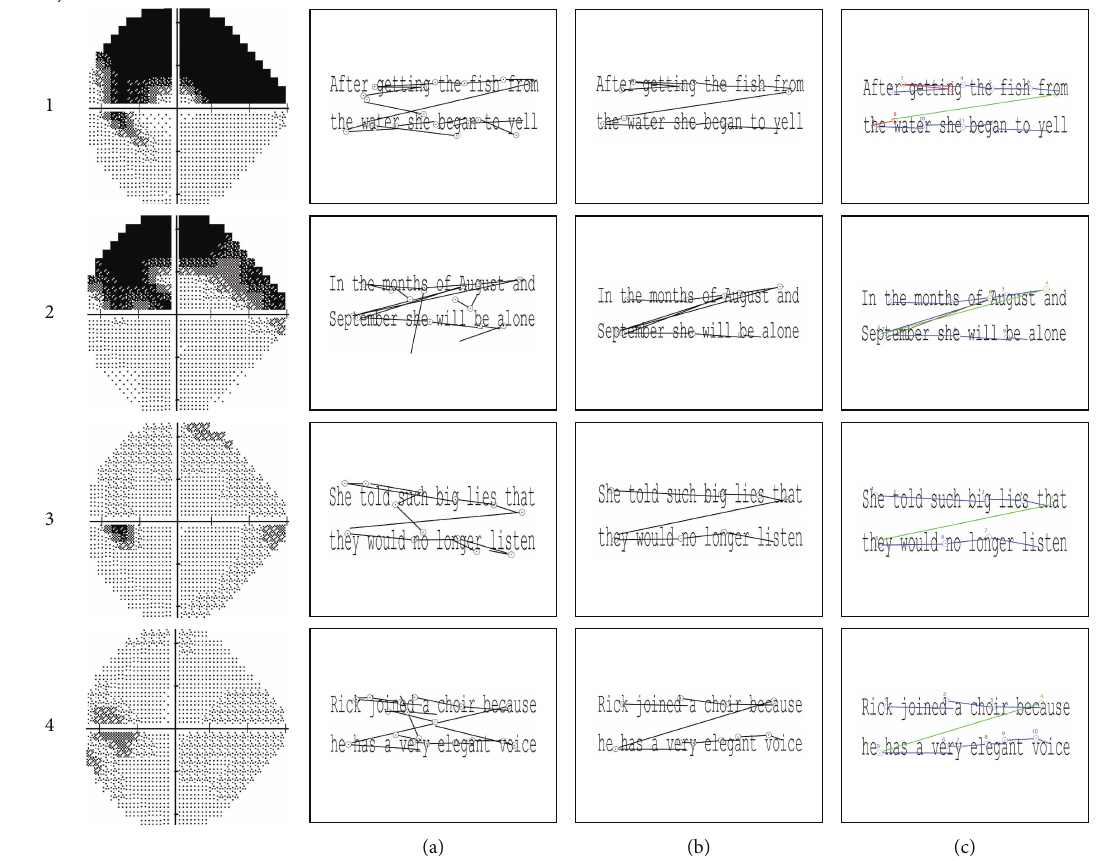
Figure 1: Four examples of scanpaths from four different glaucoma patients with their visual fields on the left. The start and end of each saccade are represented by a circle. Column (a) shows the original scanpaths made by the four participants reading the text. Column (b) shows the scanpath after the rotation has been corrected and reading-specific saccades have been extracted using the preprocessing algorithm. Column(c)showsthescanpathresultsfromtheclusteringandclassificationalgorithm.Thenumberrepresentstheorderinwhichthesaccades occurred,andthecoloursrepresenttheclassificationthatwasattributedtothembytheautomatedclusteringalgorithm(blue:forwardsaccade, green: between line saccade, red: regression, and brown: